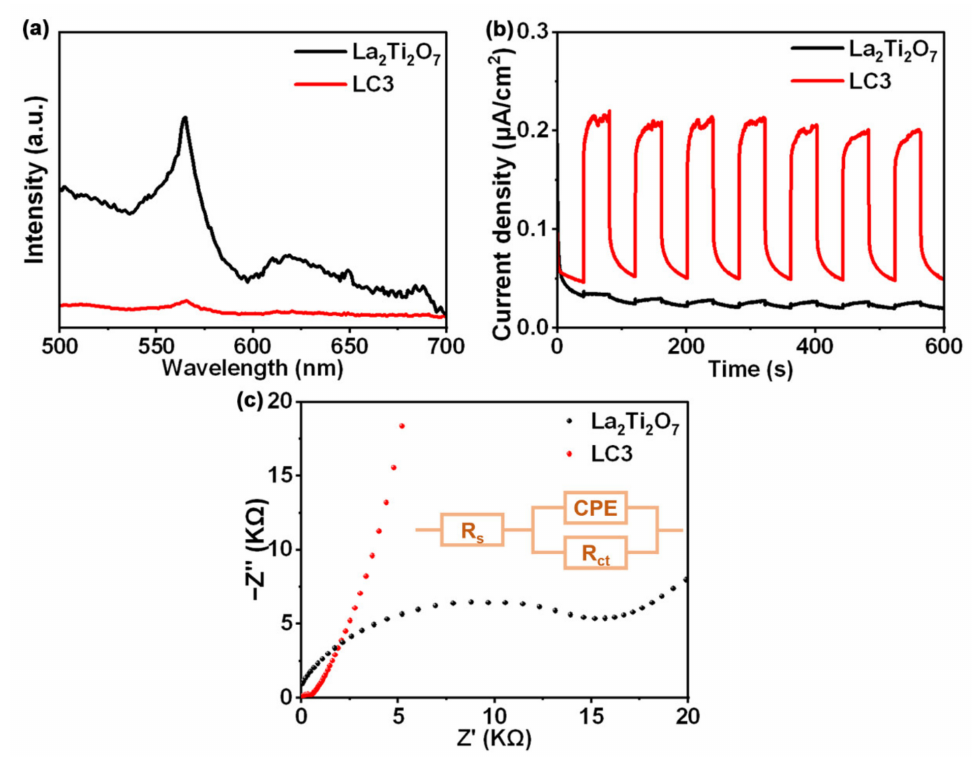
Figure 6. ( a ) Photoluminescence spectra La 2 Ti 2 O 7 and LC3; ( b ) Photocurrent responses of La 2 Ti 2 O 7 and LC3; ( c ) Nyquist plots of La 2 Ti 2 O 7 and LC3.